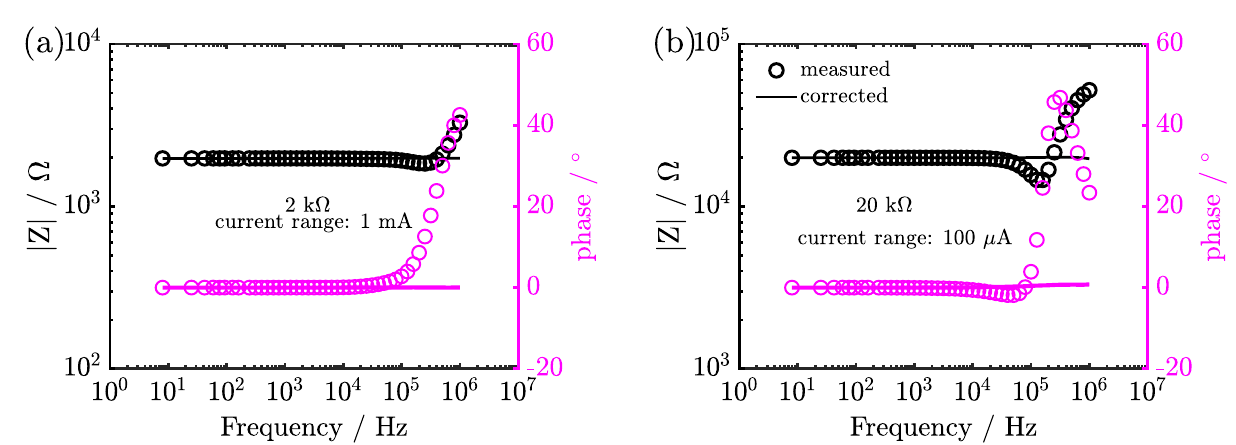
Figure 3. Correction method applied to 2 k (cid:31) at 1 mA and 20 k (cid:31) at 100 µ A current range. circle represents the measured impedance, while dash line represents the corrected impedance using the proposed